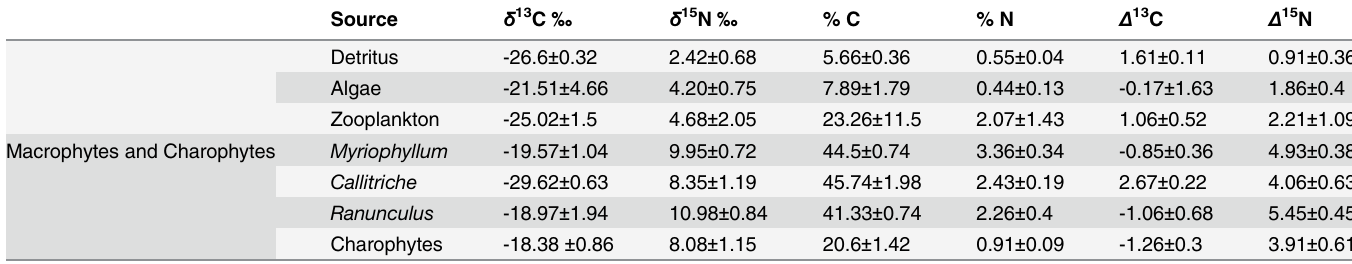
Table 3. Stable isotope composition ( δ 13 C, δ 15 N), elemental composition (%C, %N) and discrimination factor ( Δ 13 C, Δ 15 N) of the potential food sources for amphibian larvae in the experimental arrays of the study.